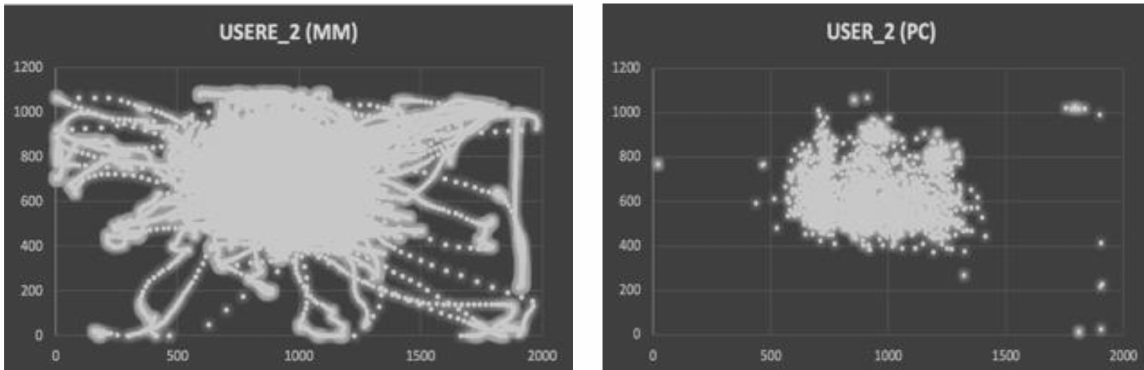
Figure 5. User 2 mouse movement, point-and-click